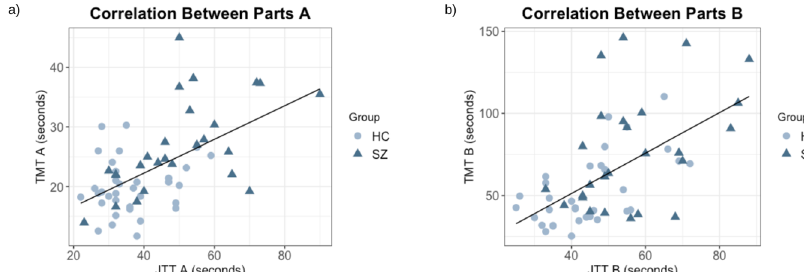
Fig. 2 Relationship between performance on smartphone app and pen-and-paper in-lab cognitive assessments at baseline. a JTT A is positively correlated with TMT A; b JTT B is positively correlated with TMT B. HC Healthy controls, SZ schizophrenia, JTT Jewels Trail Tests, TMT Trail Making Tests. Cognitive performance was measured in seconds where a greater completion time represents a worse